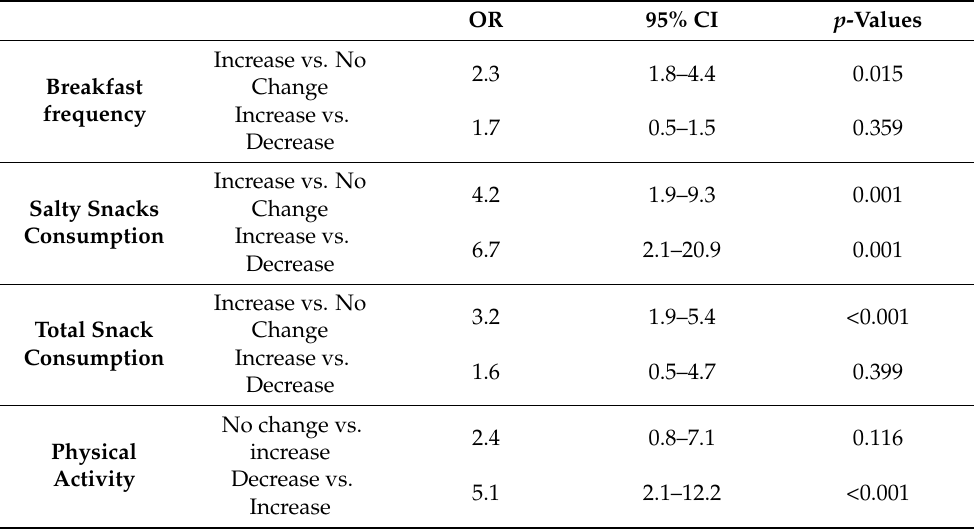
Table 6. Multiple regression analysis between the probability of children’s and adolescent’s body weight increase and dietary and lifestyle changes during the first COVID-19 lockdown in Greece. The COV-EAT